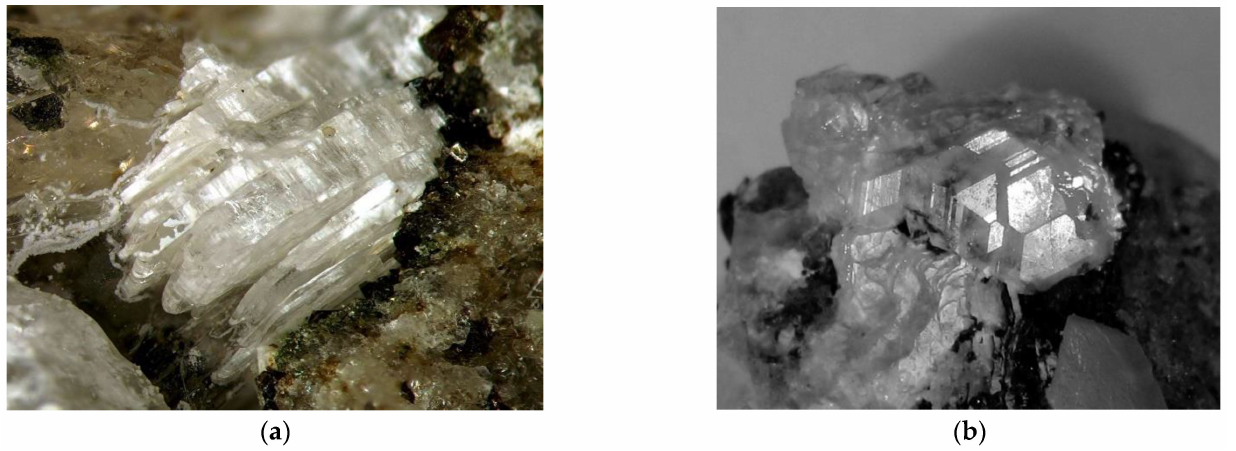
Figure 6. Crystals of biachellaite. Field of view widths: 5 mm ( a ) and 6 mm ( b